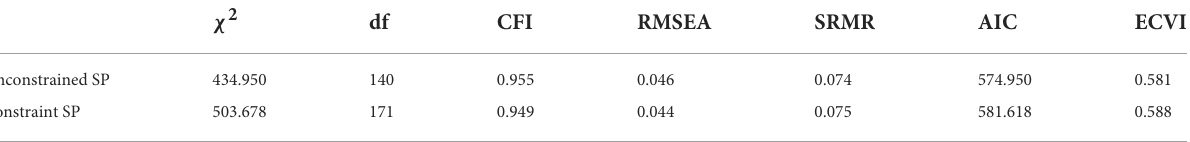
TABLE 4 Comparison of unconstrained and constrained structural path